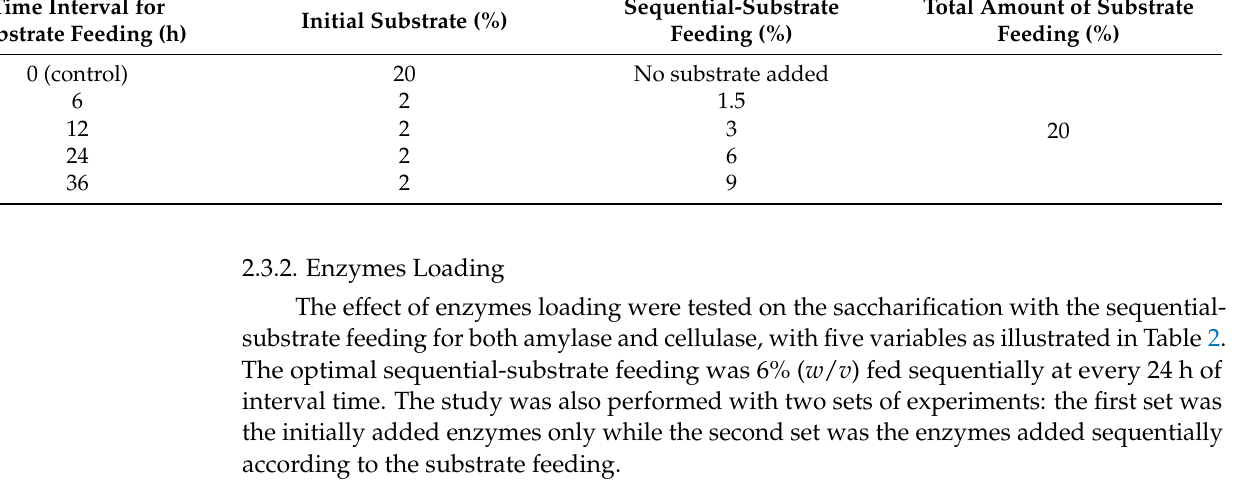
Table 1. Feeding strategies for the feeding interval of sago hampas on the saccharification process. Time Interval for Initial Substrate (%) Substrate Feeding (h) 0 (control)